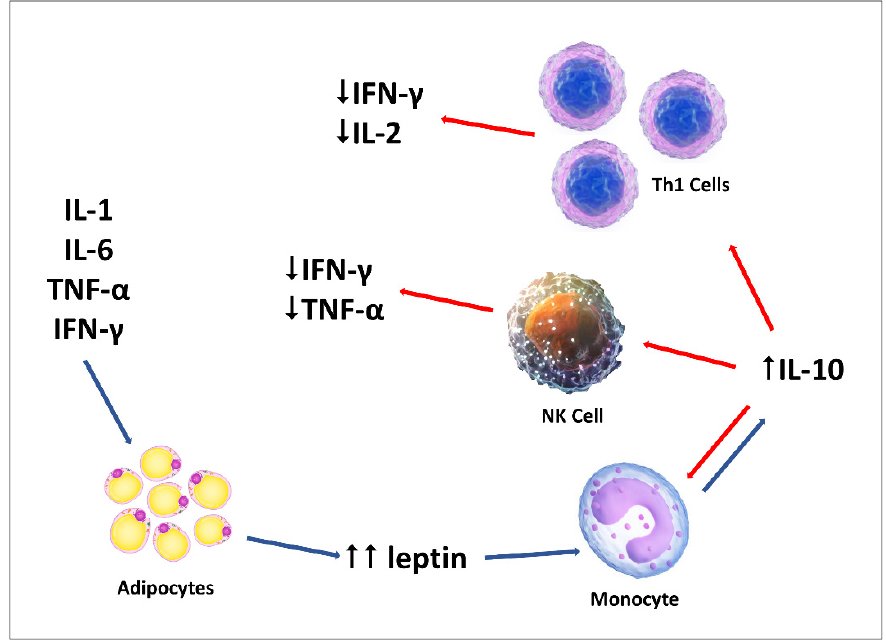
Figure 7. Proposed mechanism of the anti-inflammatory role of leptin in childhood ITP. The red and blue arrows denote down- and upregulation, respectively (adapted from [59]).